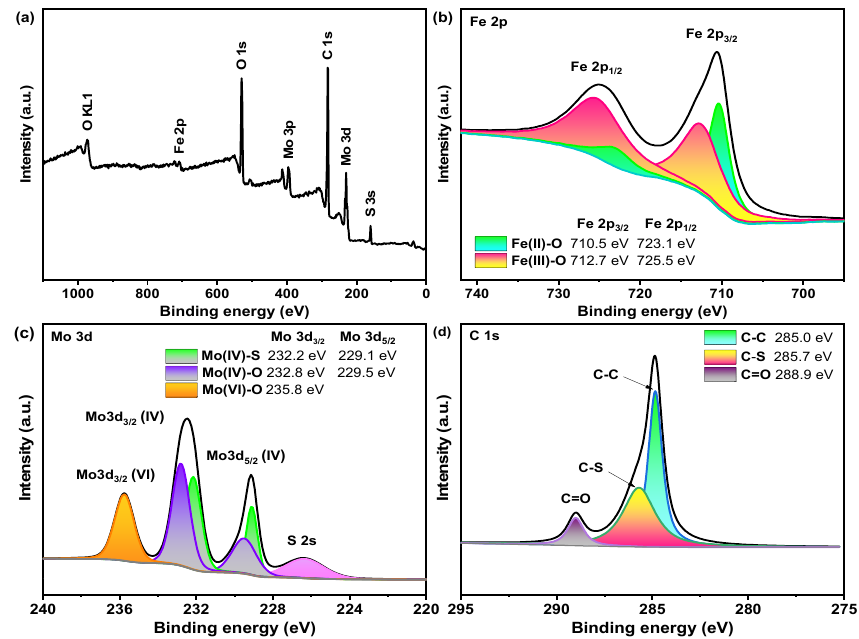
Figure 3. XPS spectra of Fe-Mo/rGO catalyst. (( a ) full spectrum; ( b ) Fe 2p; ( c ) Mo 3d; ( d ) C 1s).